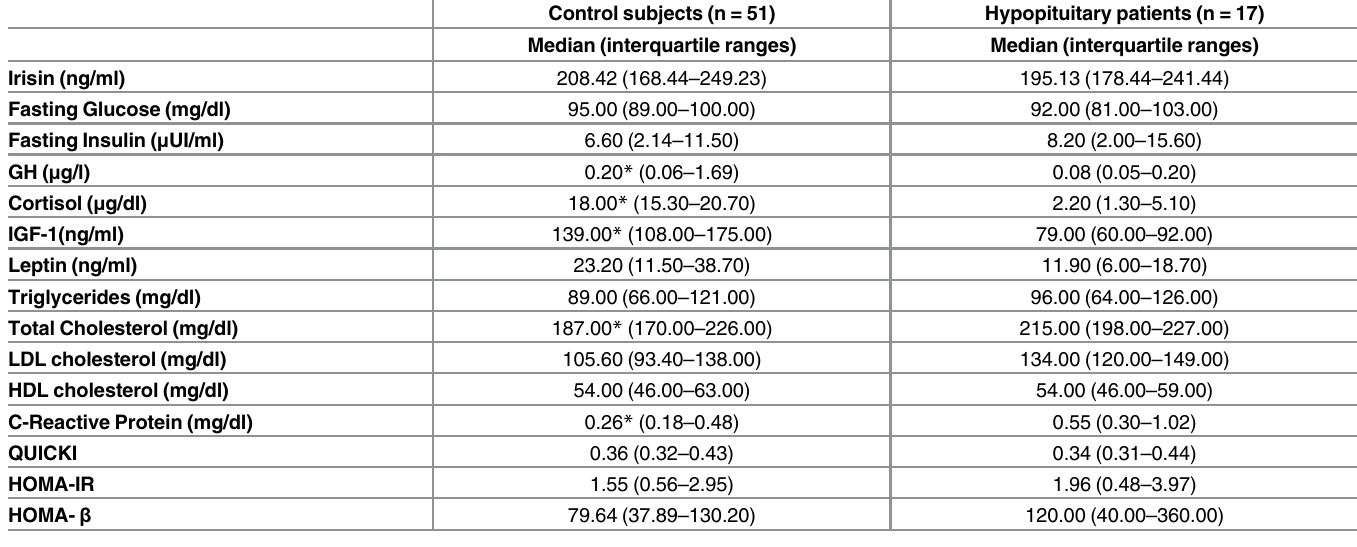
Table 2. Biochemical and Hormonal data (median, interquartile ranges) in hypopituitary patients and control